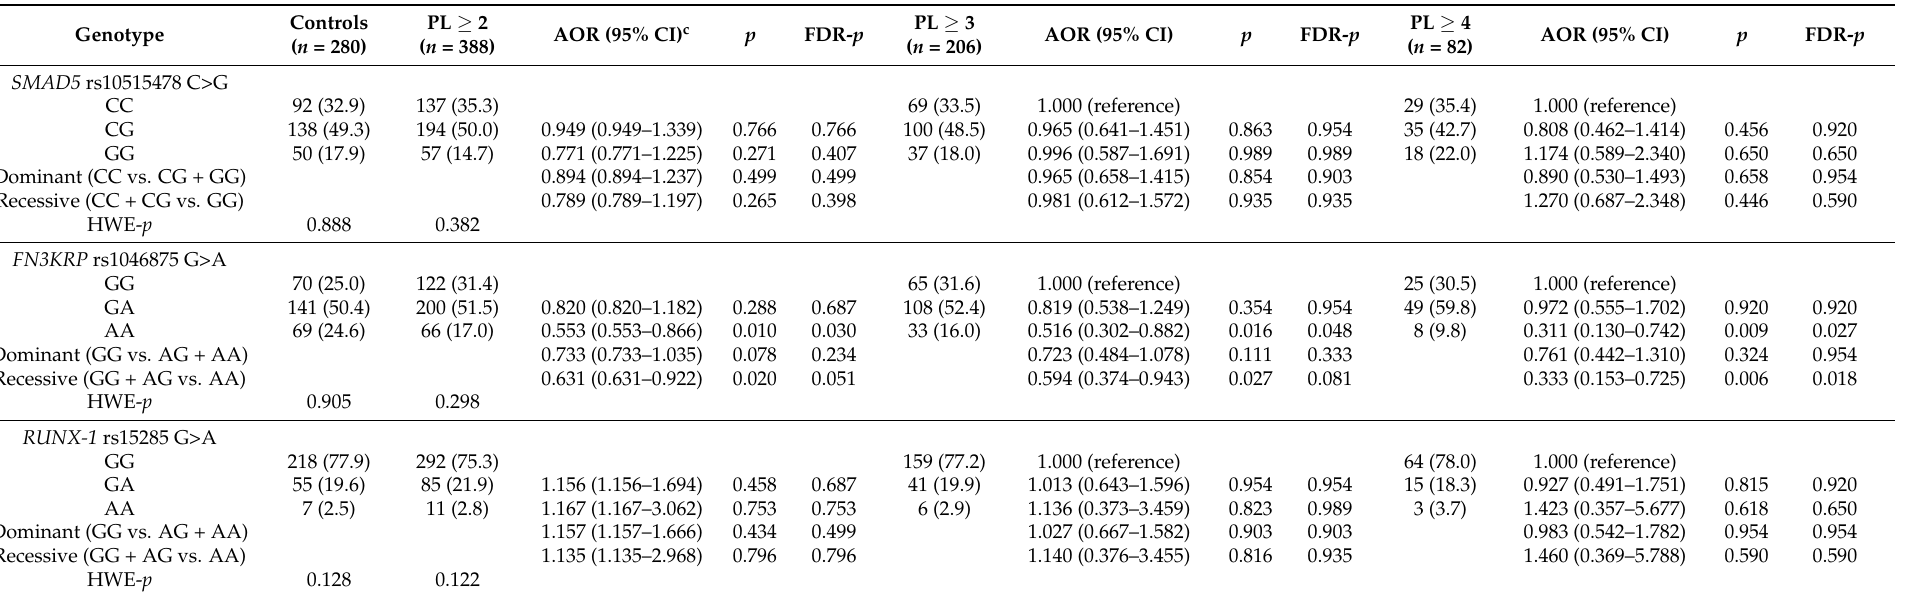
Table 2. Genotype frequencies of gene polymorphisms in control and RPL